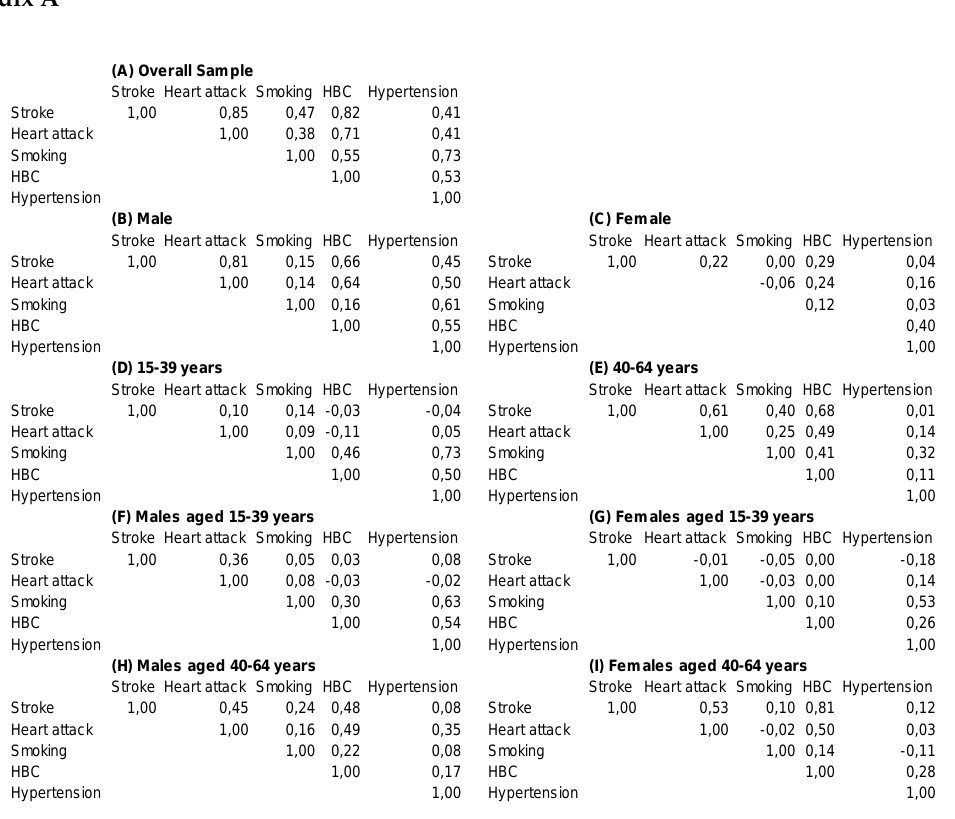
Figure A1. Correlations between CVDs and their risk factors.